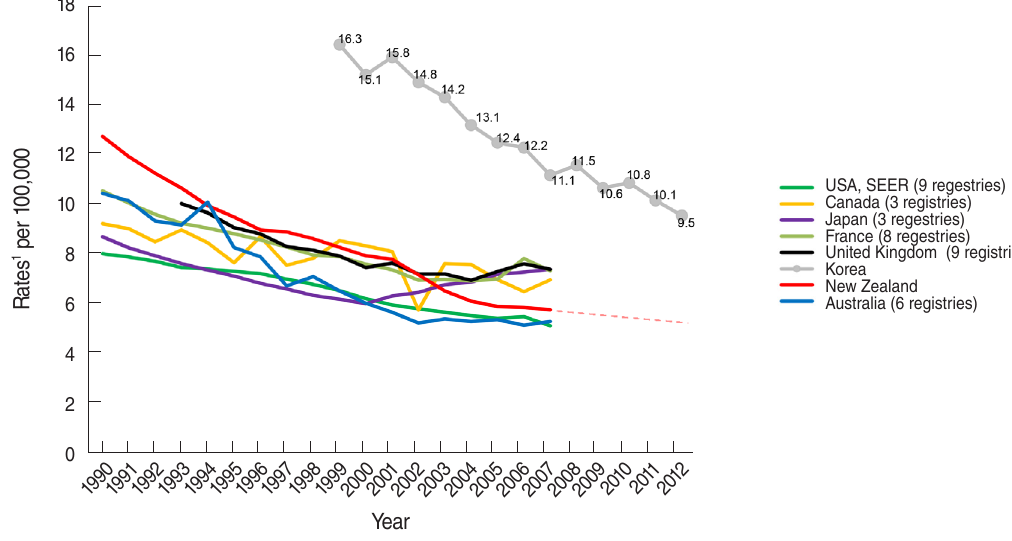
Figure 3. Trends of incidence rates of cervical cancer, worldwide, 1990-2012 2 . Source from International Agency for Research on Cancer. GLOBOCAN 2012: estimated cancer incidence, mortality and prevalence worldwide in 2012; 2014 [17]; International Agency for Research on Cancer. Cancer incidence in five continents volume X(CI5X); 2013; 2014 [18]. SEER, Surveillance, Epidemiology, and End Results. 1 Age- adjusted to Segi ‘s world standard population; ASR, age-standardized rates. 2 Estimated incidence rate in ASR (W), 2012: the estimates inci- dence rates in the year of 2012 are representable for each country as a whole while the data from CI-5 were collected selectively by cancer registry regions.